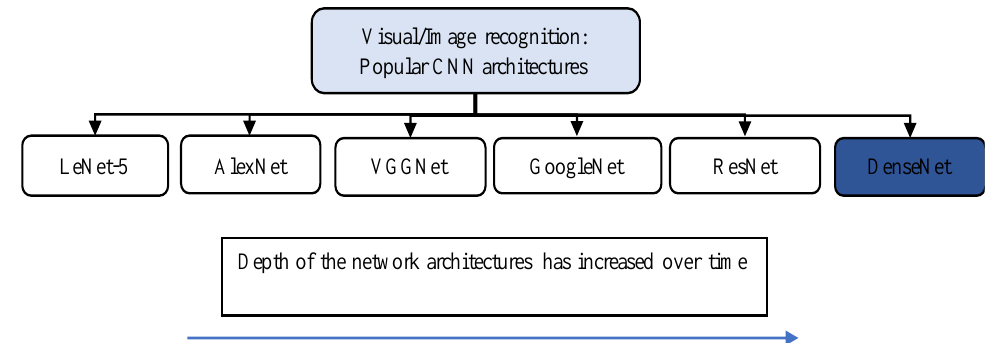
Figure 1. State-of-art image recognition CNN networks. The trend is that the depth and discrimina- tory powers of network architectures increases from formerly proposed architectures towards the recently proposed architectures.